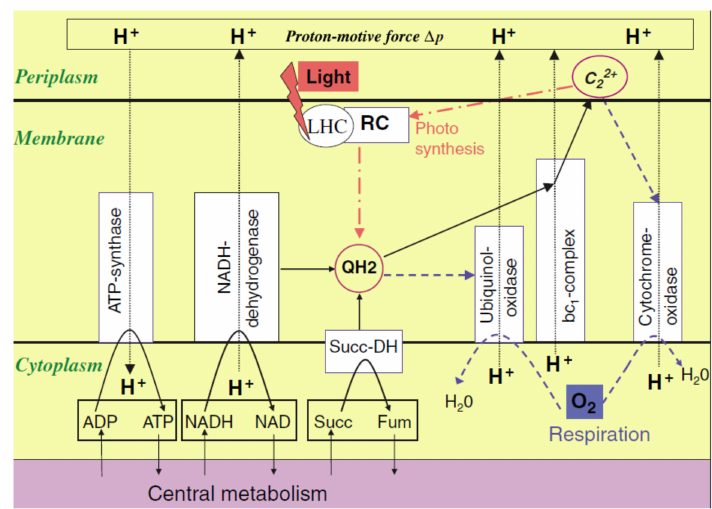
Figure 6. The photophosphorylation and oxidative phosphorylation pathways of purple non-sulfur bacteria. The nicotinamide adenine dinucleotide (NADH) dehydrogenase catalyzes a reduction of the redox carrier ubiquinone (Q) to ubiquinol (QH 2 ). This process is coupled to the translocation of protons from the cytoplasm to the periplasm. The succinate dehydrogenase (Succ-DH) oxidizes succinate to fumarate and transfers the two electrons to Q. The heme-containing ubiquinol oxidase, which is also acting as a proton pump, transfers electrons from QH 2 to oxygen. The cytochrome bc 1 complex mediates the transfer of electrons from the ubiquinol pool to the second type of diffusible redox carrier in the membrane, the cytochrome c 2 , and pumps protons into the periplasm. The cytochrome c oxidase oxidizes two molecules of cytochrome c 2 and reduces oxygen to water, thereby translocating protons into the periplasm. The photosynthetic apparatus comprises a reaction center (RC) and a light-harvesting complex (LHC) and is involved in the transfer of electrons from cytochrome c 2 to QH 2 . This light-driven transfer is special because it proceeds from high to low redox potential. Finally, the adenosine triphosphate (ATP) synthase converts the energy stored solely photosynthetic or respiratory are indicated by red dashed–dotted and blue dashed